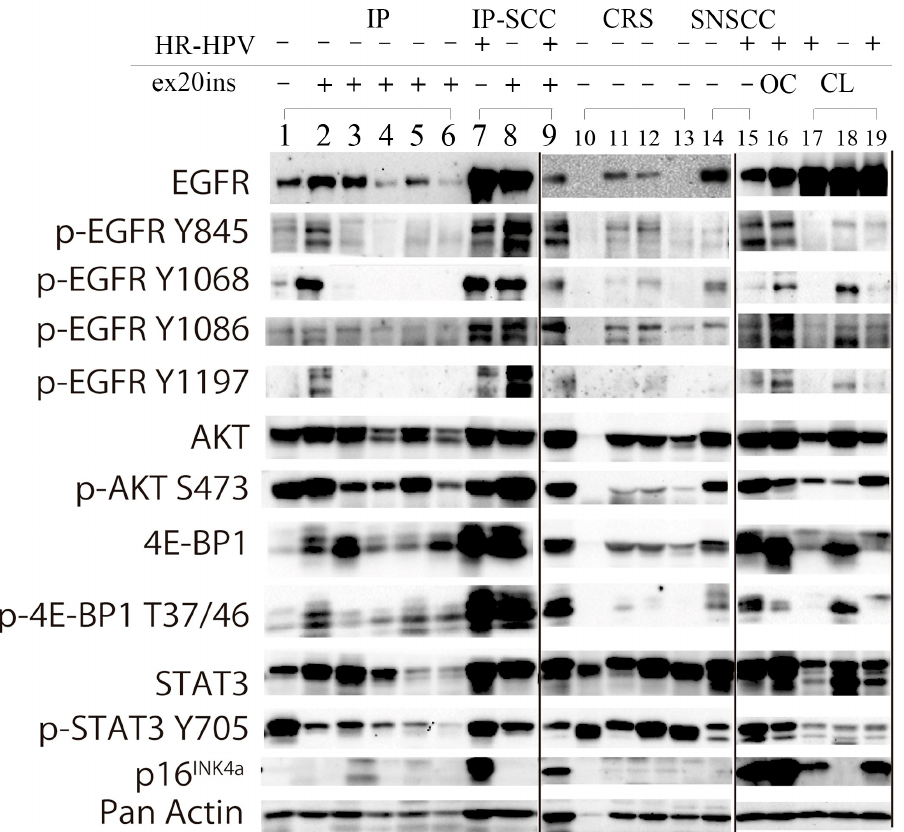
Figure 3. Western blot analysis of IP, IP-SCC, SNSCC, and chronic rhinosinusitis cases. EGFR and